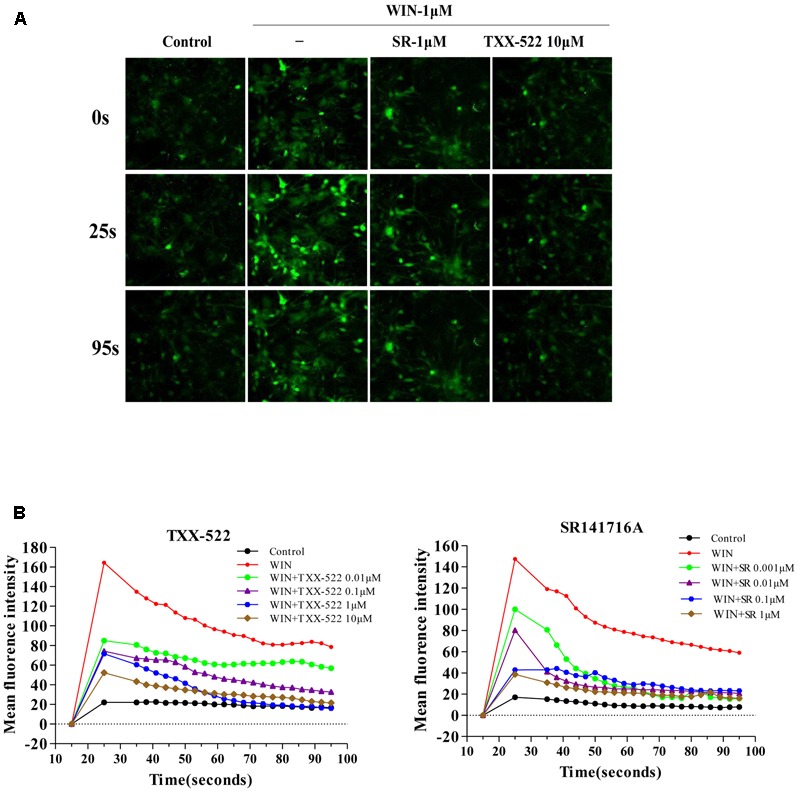
Effects of TXX-522 on WIN 55,212-2-mediated elevation of [Ca2+]i. (A) Representative micrographs showing [Ca2+]i in hippocampal cells at indicated time-points. WIN, WIN 55,212-2; SR, SR141716A. (B) Dynamic course [Ca2+]i elevation and pulse oscillation in cells exposed to indicated concentrations of WIN and TXX-522 or SR141716A.